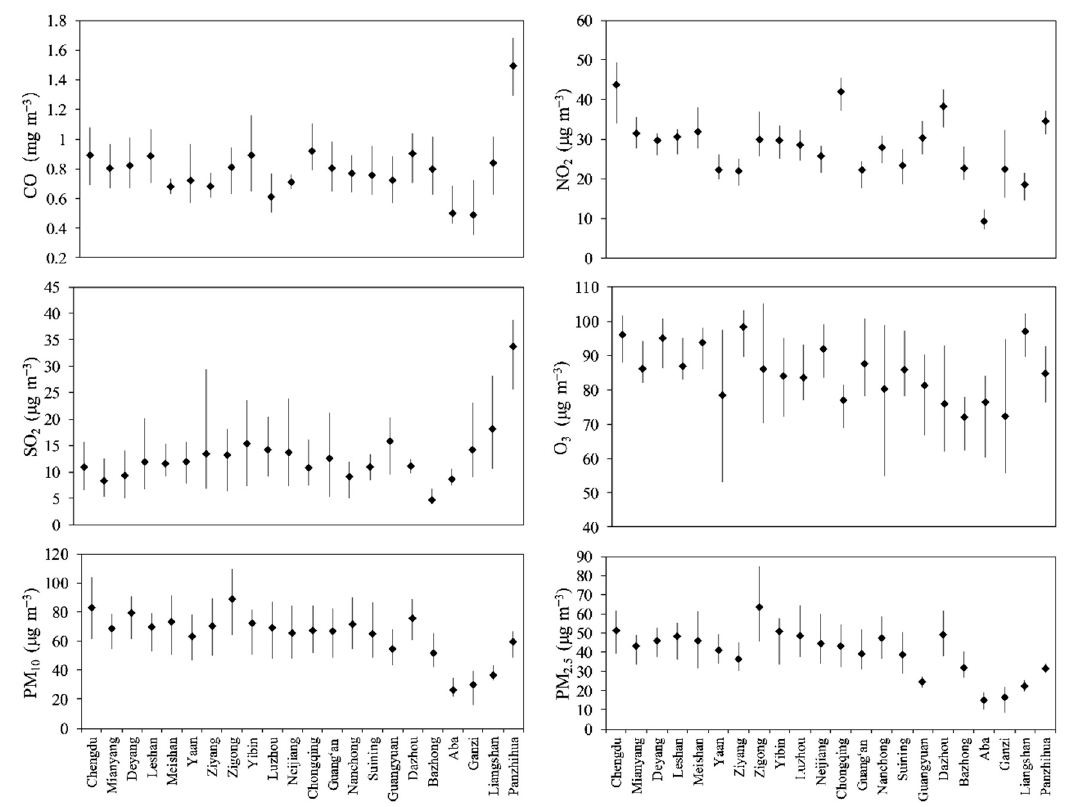
Figure 2. The annual average concentrations of pollutants in Sichuan Basin. The filled circle represents the mean concen- tration whereas the error bar denotes the range of the annual concentration. The data used in each city comes from every station during 2015–2020.